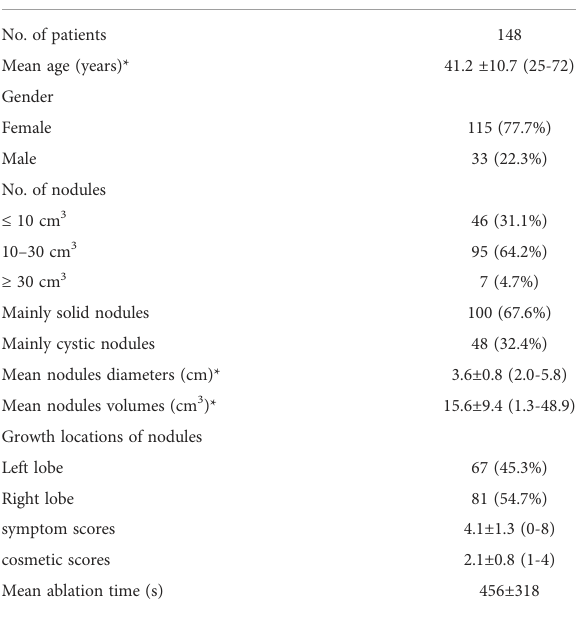
TABLE 1 The clinical features of patients and